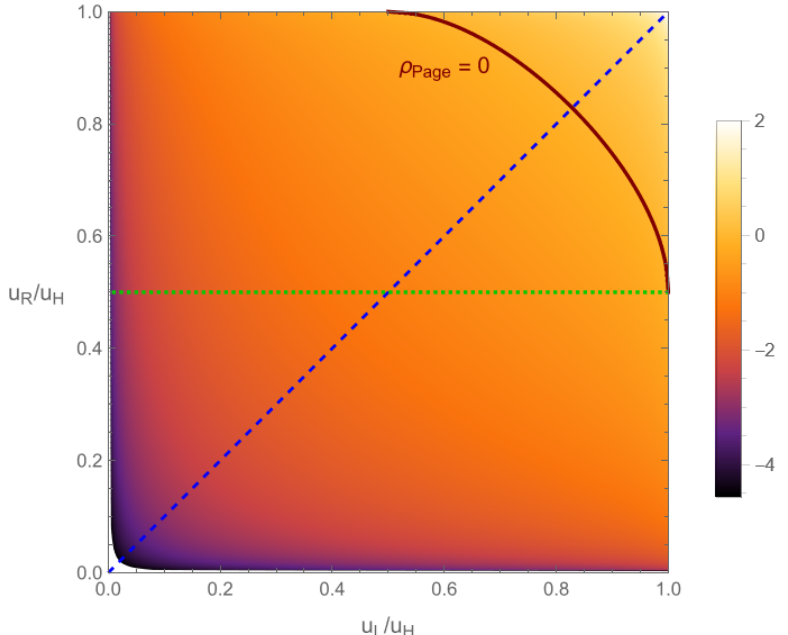
Figure 8 . A density plot of the Page angle ρ Page with respect to both u L and u R . The contour with ρ Page = 0 is shown in maroon as a point of reference. Drawn in dashed blue and dotted green are the slices of the parameter space shown in figures 9 and 10,